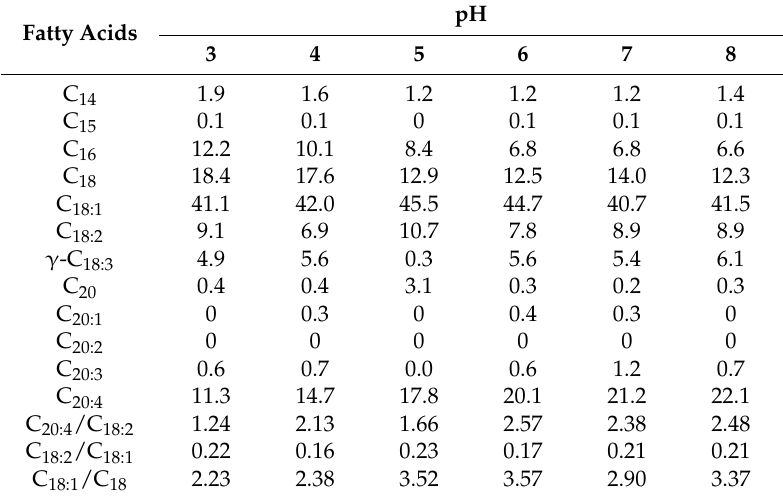
Table 3. The effect of pH on the fatty acid composition (% of lipids) of M. alpina NRRL-A-10995 in the exponential phase.